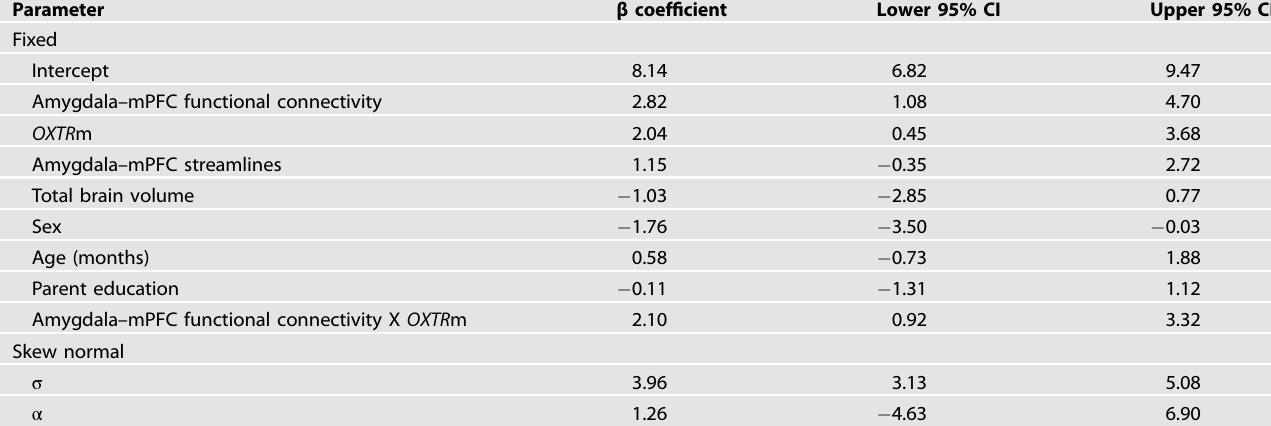
Table 2. Population parameter estimates and uncertainty for full model predicting self-reported internalizing behaviors at the 2-year follow-up. Parameter